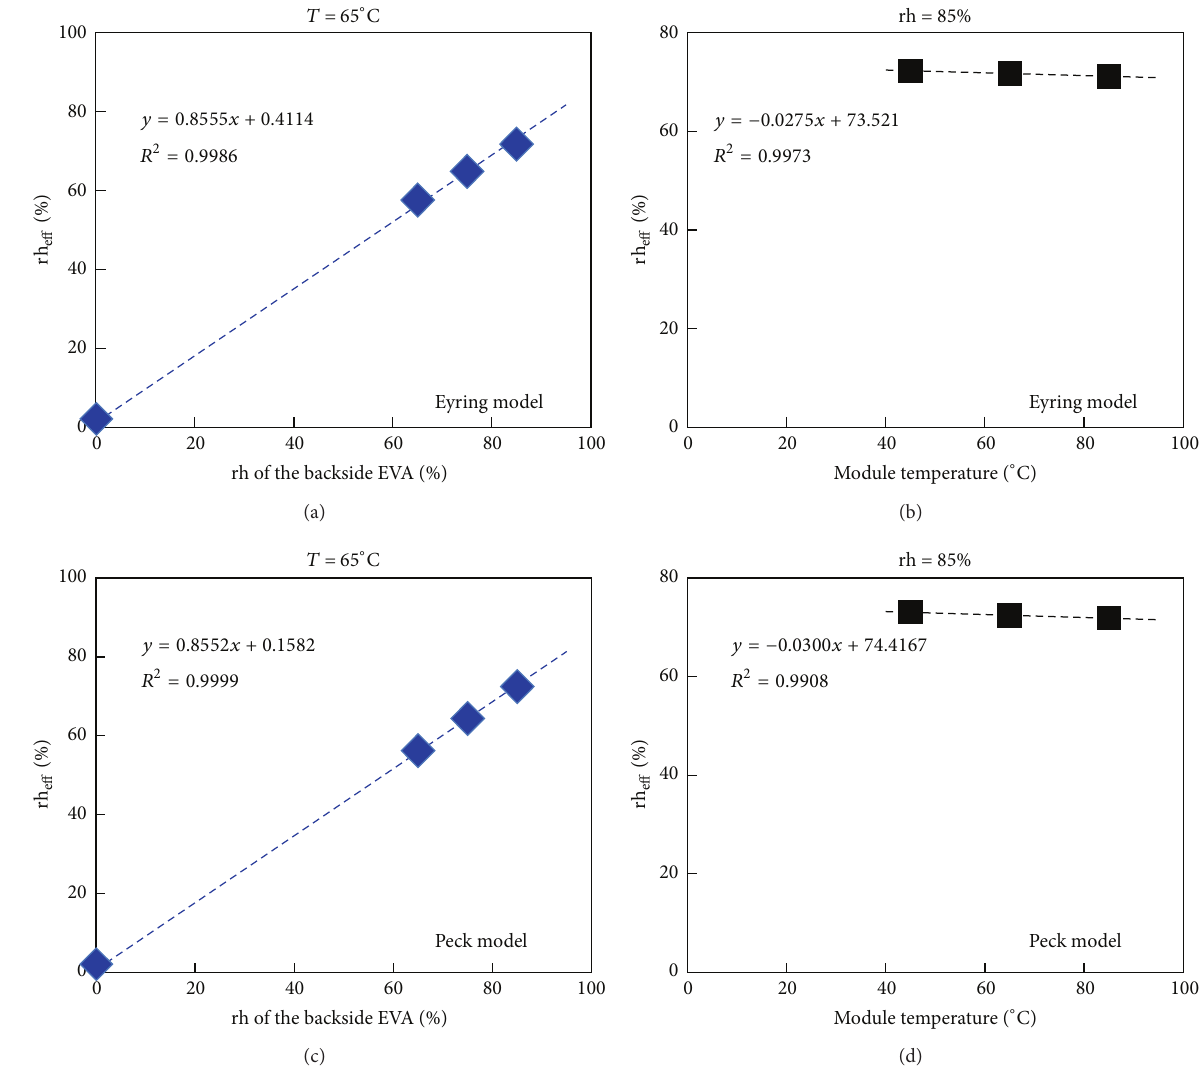
Figure 3: rh eff versus rh for the backside EVA and rh eff versus module temperature are plotted for two 𝑅 𝐷 prediction models: (a) rh eff versus rh for the backside EVA at constant temperature for Eyring model, (b) rh eff versus module temperature at constant humidity for Eyring model, (c) rh eff versus rh for the backside EVA at constant temperature for Peck model, (d) rh eff versus module temperature at constant humidity for Peck